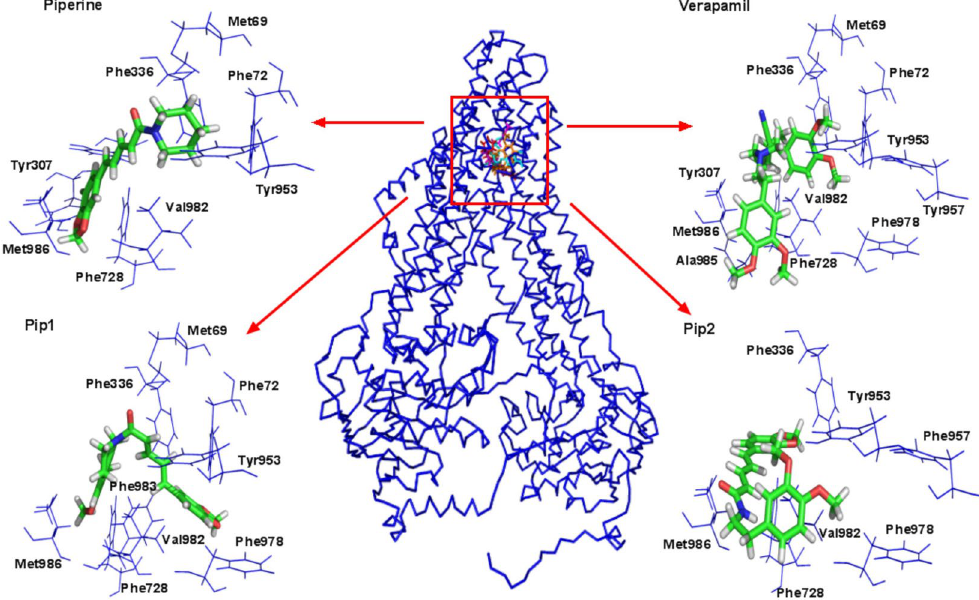
Figure 3. 3D interactions of human P-gp with piperine, verapamil and piperine analogs (Pip1 and Pip2) predicted by docking studies conducted using Glide XP